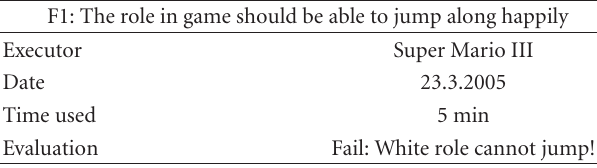
Table 4: Attributes of functional requirements. F1: The role in game should be able to jump along happily